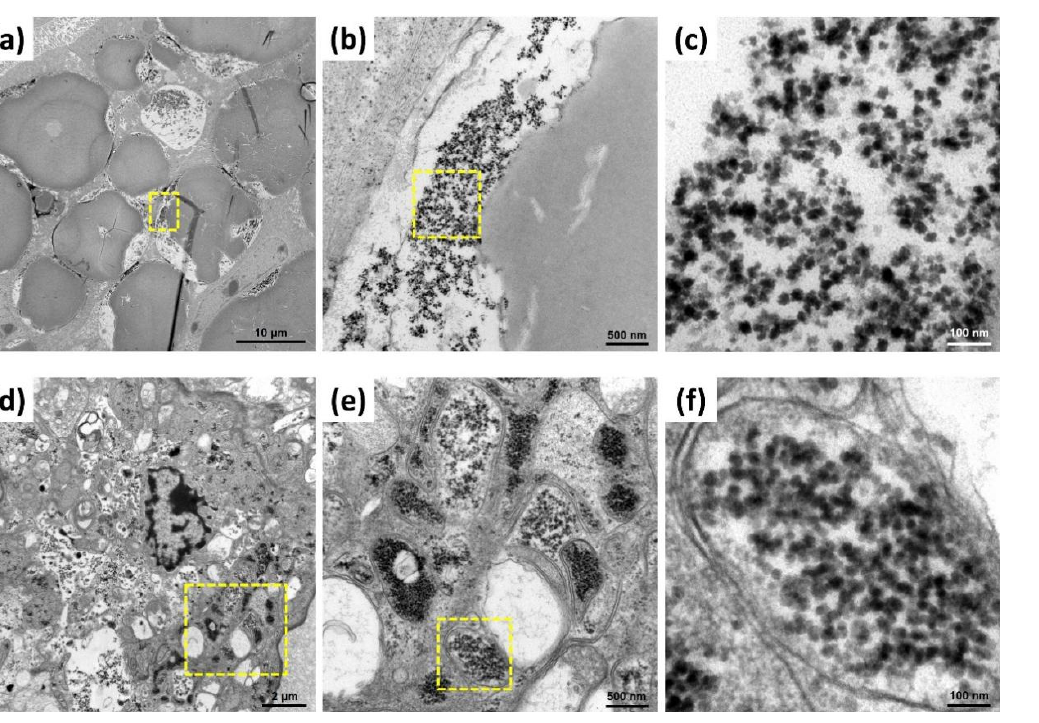
8 of 12 Figure 3. Micrographs of histopathological and in situ hybridization (ISH) assays for the gill and gonad from Macrobrachium rosenbergii naturally infected by covert mortality nodavirus (CMNV). ( a ) ISH micrographs of gill. ( b ) Magnified view of the red-framed areas of ( a ). Note the bluish-purple hybridization signals of CMNV probe. ( c ) H&E staining micrographs of gill histological section. ( d ) Magnified view of the red-framed areas of ( c ). Note the gill tissue edema, extensive vacuolation (hollow arrows) and karyopyknosis (thick black arrows). ( e ) ISH micrographs of gonad histological section. ( f ) Magnified view of the red-framed areas of ( e ). Note the bluish-purple CMNV positive hybridization signals. ( g ) H&E staining micrographs of gonad histological section. ( h ) Magnified